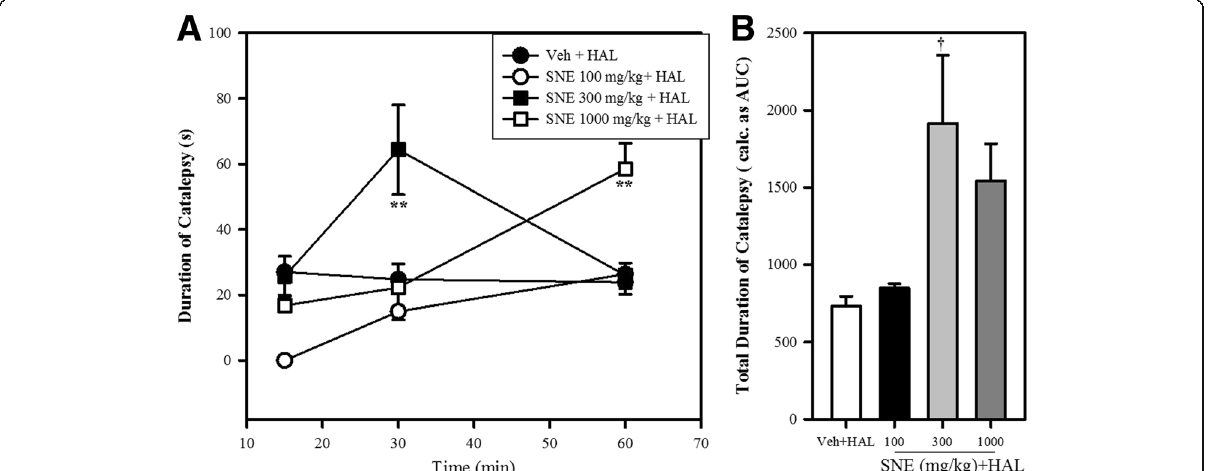
Fig. 10 Effects of SNE on haloperidol (HAL)-induced catalepsy in mice. Left paneled graph (A) is the time-course effects 15, 30 and 60 min post haloperidol administration. Column graph (B) is the total duration of catalepsy (calculated as AUCs from the time-course graphs). Data are mean ± SEM ( n = 5). ** P ≤ 0.01 compared with vehicle group (two-way ANOVA followed by Bonferroni posthoc test). † P ≤ 0.05 compared with vehicle group (one-way ANOVA followed by a Dunnett ’ s multiple comparison post hoc